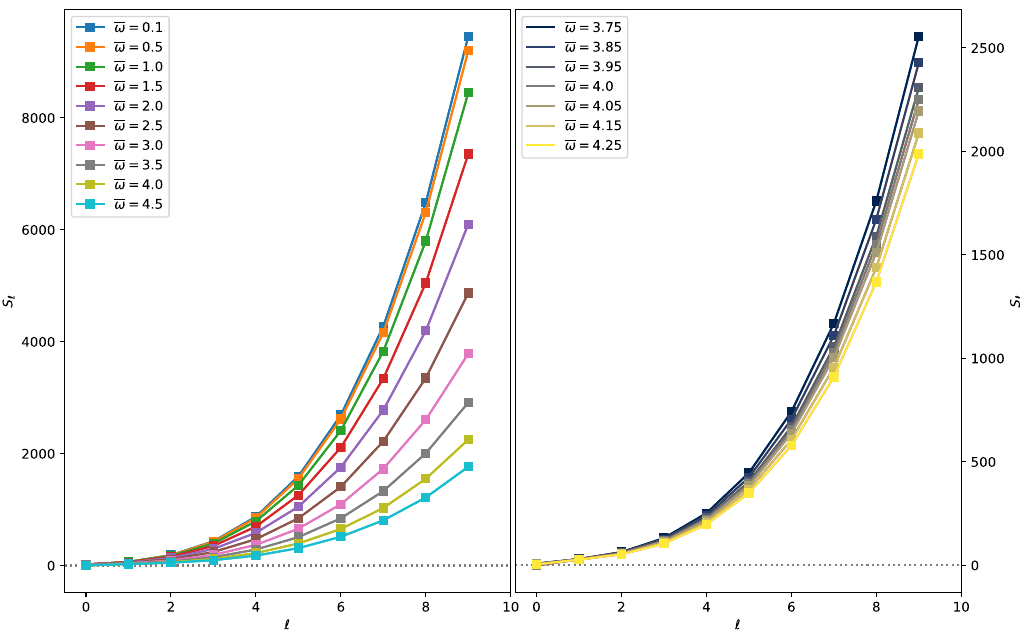
Figure 1. Left: evaluating (3.6) when m 2 = 0 for various choices of ω . Right : the behaviour of S ‘ for ω values near ω 0 .